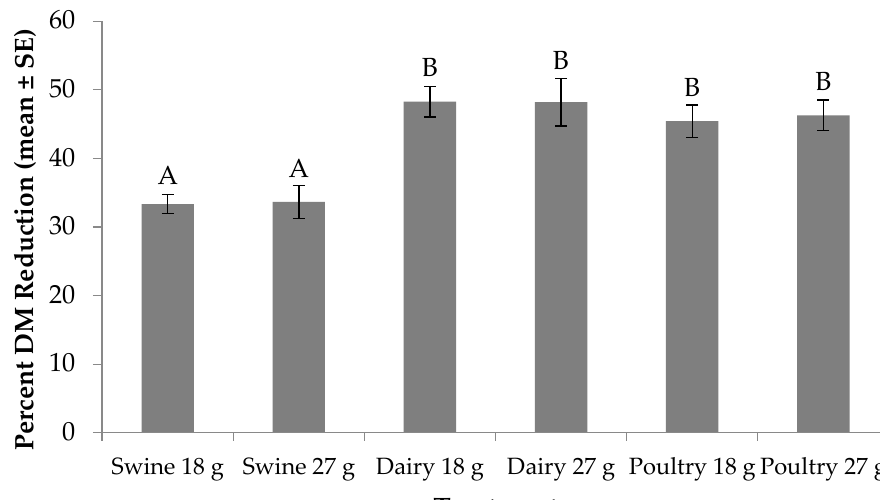
Figure 1. Percent dry matter (DM) reduction (mean ± SE, 1 n = 6) for black soldier fly larvae fed swine, dairy or poultry manure at two feed rates every other day at 29 °C, 60% RH, and 16L:8D. Different letters indicate significant differences between treatments (α = 0.05), ANOVA followed by Tukey’s HSD (honest significant difference). 1 n = number of replicates per treatment.